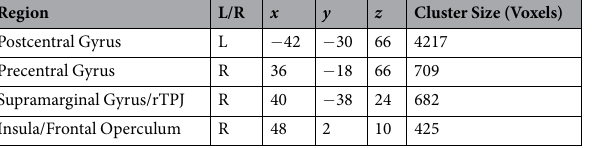
Table 2. (Identical In-group and Different In-group) > Out-group/In-group: Repetition Enhancement. Coordinates refer to peak voxel in Montreal Neurological Institute stereotaxic